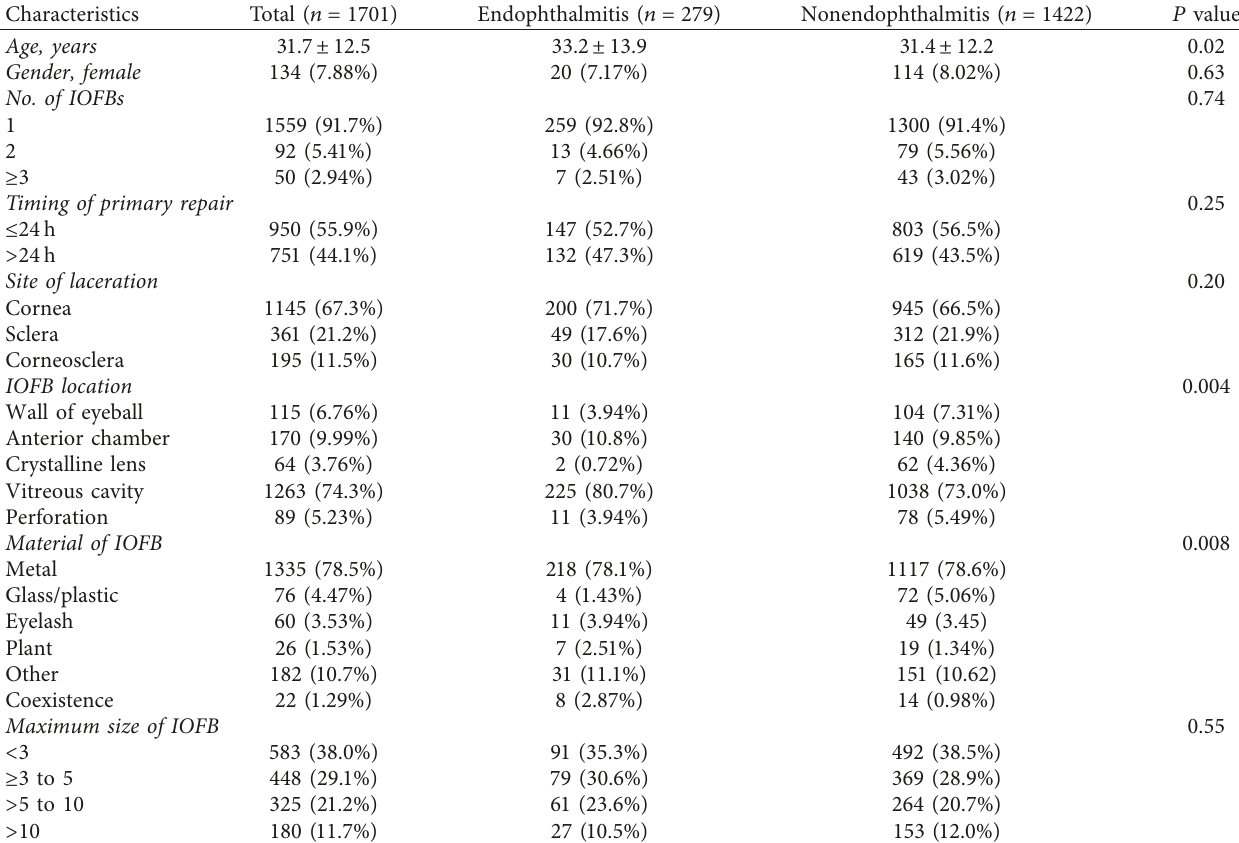
Table 1: Comparison of study participants with and without endophthalmitis.